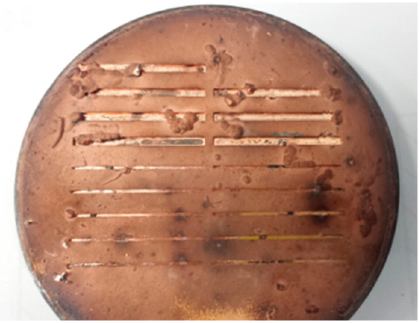
Figure 8. Optical microscope photograph of of the sample with 18 channels after SU ‐ 8 removal: 8 channels above for WR2.8, and 10 channels below for WR1.5. Table 4. Copper electroforming parameters.